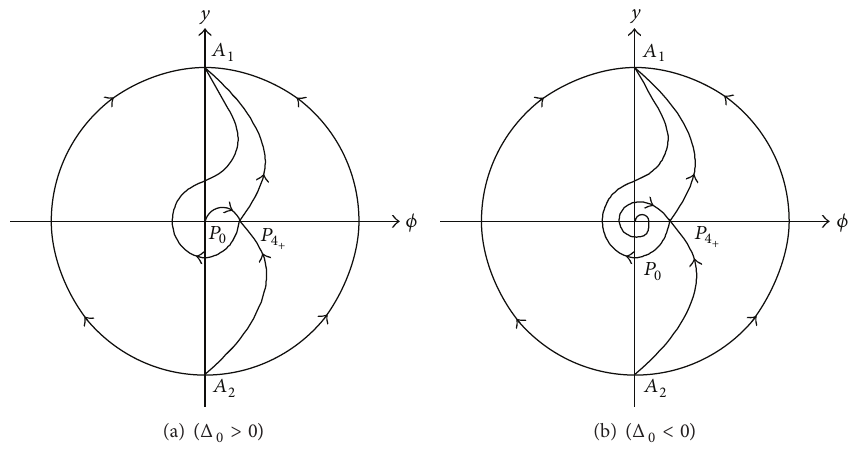
Figure 8: ( 𝛽 > 0 , 𝑎 < 0 , 𝑏 = 0 , 𝑐 < 0 ).